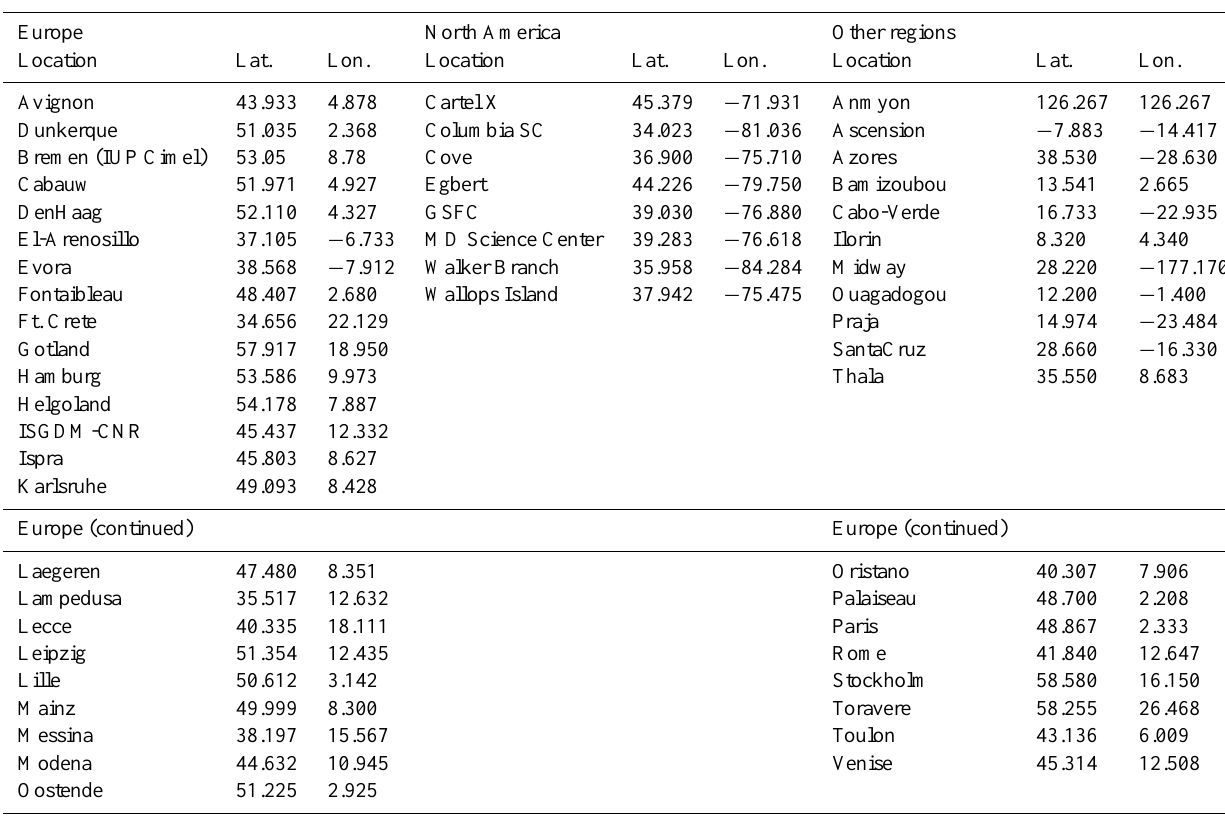
Table 5. AERONET sites used in validation studies of BAER. Latitudes and longitudes are given in degrees. Europe